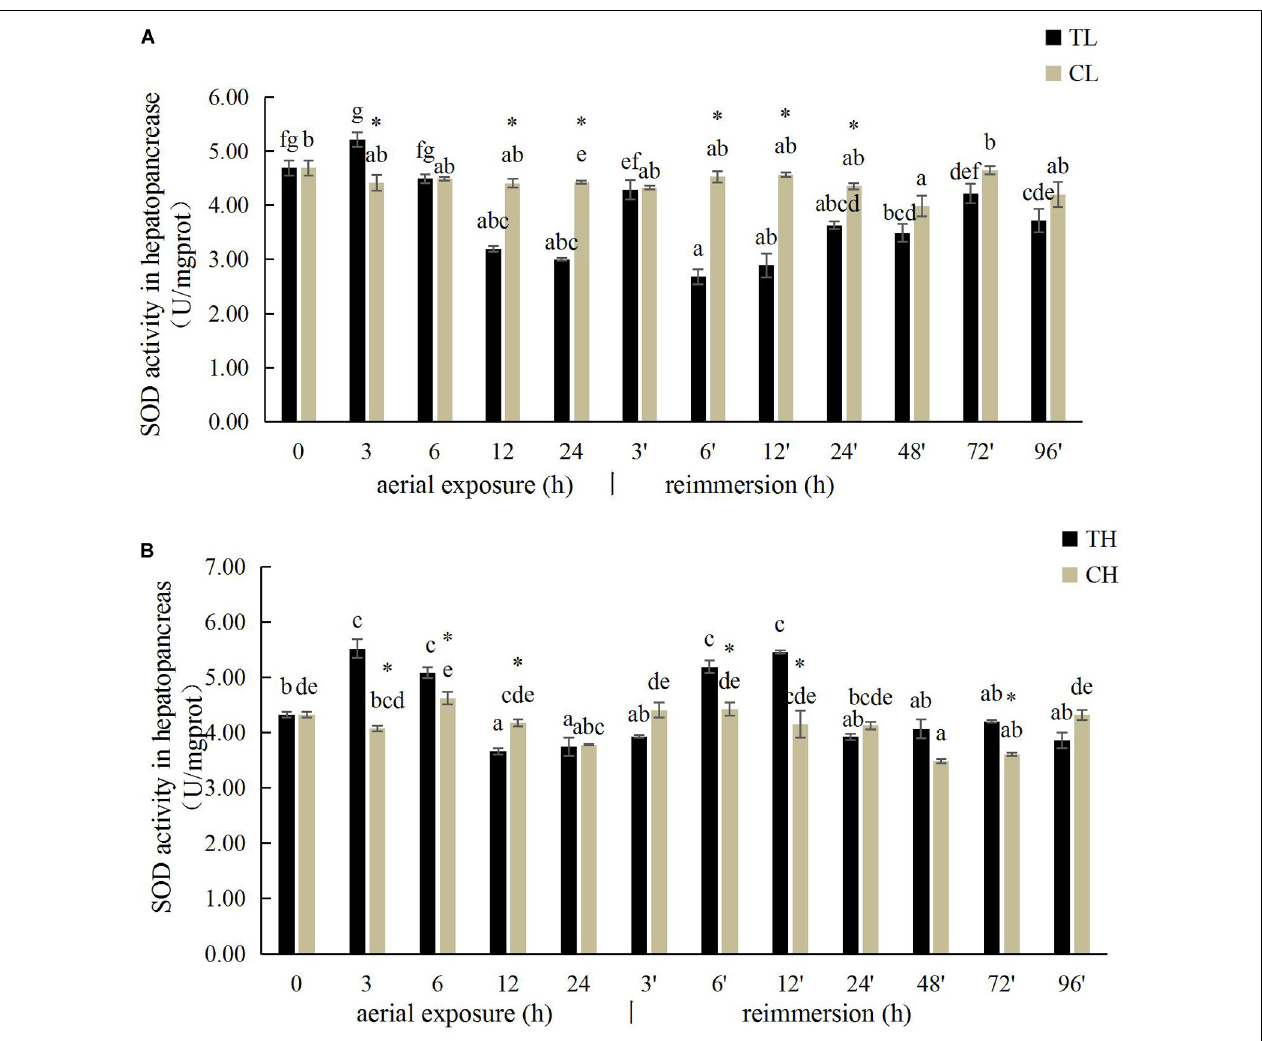
FIGURE 4 | Effects of aerial exposure on superoxide dismutase (SOD) in hepatopancreas of R. philippinarum under low temperature (A) and high temperature (B)